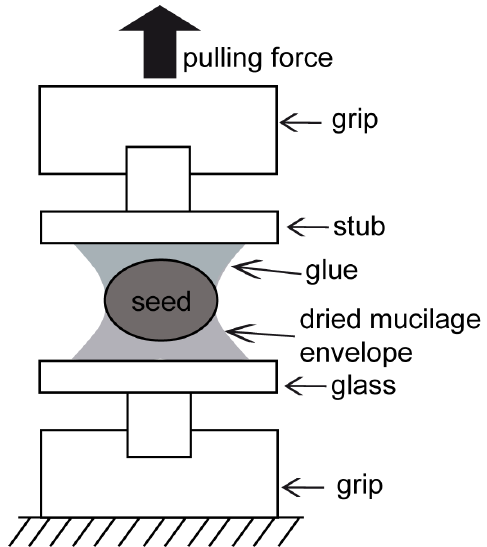
Figure 1. Probe fixation in pull-off experiments. The sample with the seed was placed between two grips: the lower one was motionless and the upper one moved upwards. The lower seed surface was attached to the aluminum SEM stub by the dried mucilage envelope. The upper (mucilage free) seed surface was glued to the SEM stub by the commercial glue. The upper grip moved up and stopped when the seed was detached from the glass slide.